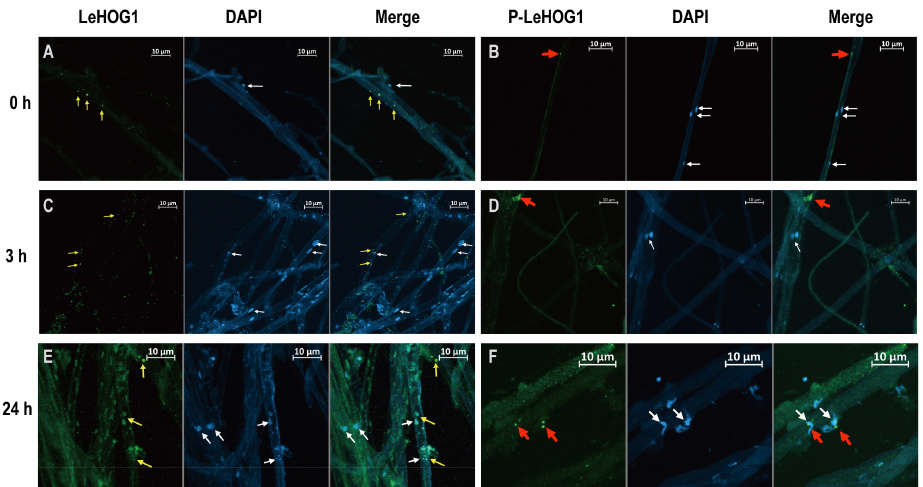
Figure 4. Subcellular localisation of LeHOG1 and phospho-LeHOG1 in mycelia treated with 100 µM H 2 O 2 . ( A , C , E ) Immuno fl uorescence of LeHOG1-labelled (green) and DAPI-stained (blue) mycelia after 0, 3, and 24 h of treatment. ( B , D , F ) Immuno fl uorescence of phospho-LeHOG1-labelled (green) and DAPI-stained (blue) mycelia after 0, 3, and 24 h of treatment. Yellow arrows indicate LeHOG1- labelled mycelia. Red arrows indicate phospho-LeHOG-labelled mycelia. White arrows indicate nu- clei.